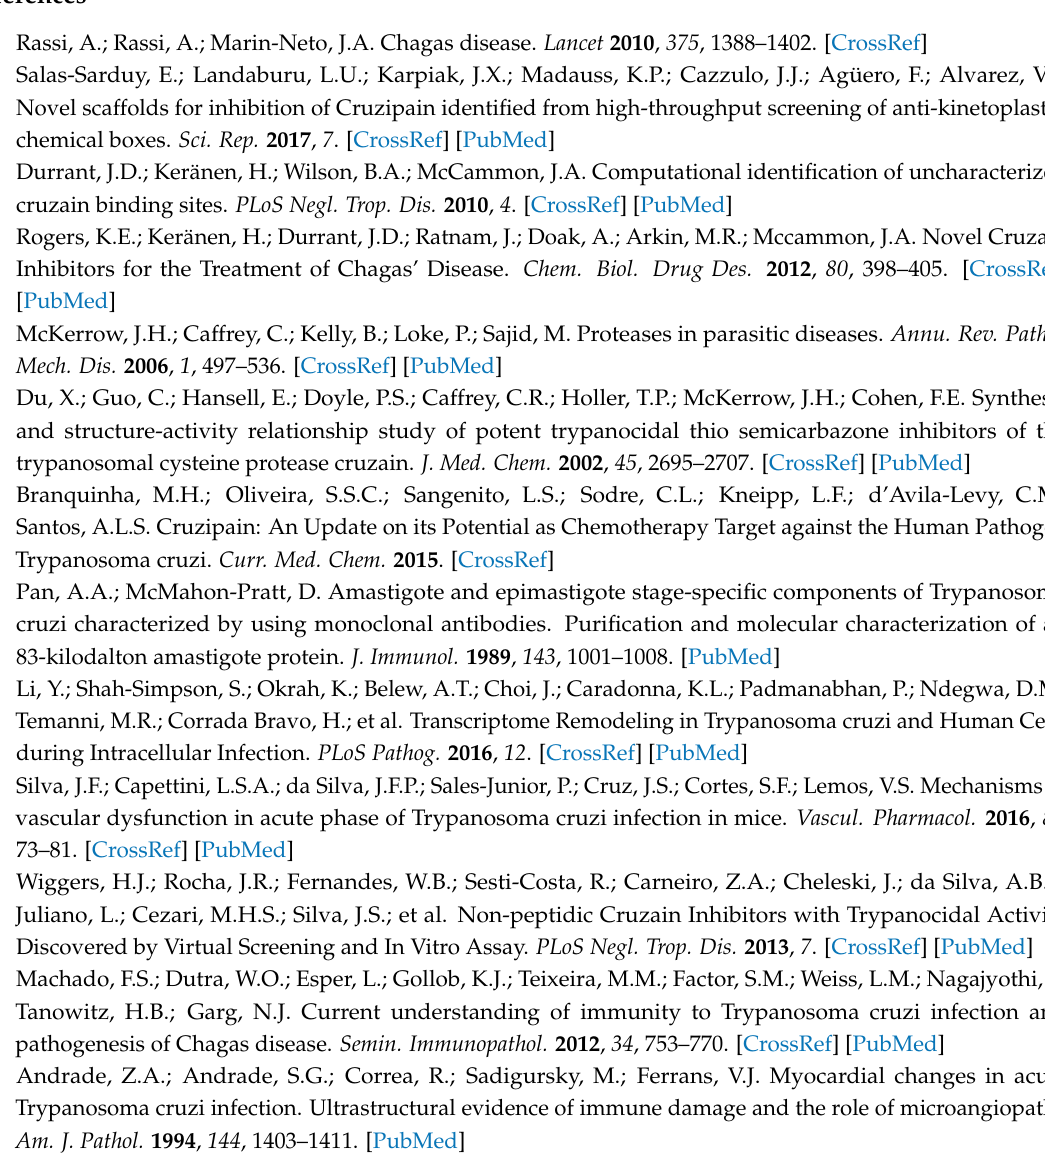
Supplementary Materials: Supplementary figures: Supplementary Figure S1. 2D structures of 8 highest dock scored ligands. Supplementary Figure S2. 2D representation of detailed molecular interaction between the protein and the ligands. Supplementary Figure S3. Aligning of the Co-crystal (pink) overlapped with its docked pose (blue). Supplementary Figure S4. Location of four residues forming a